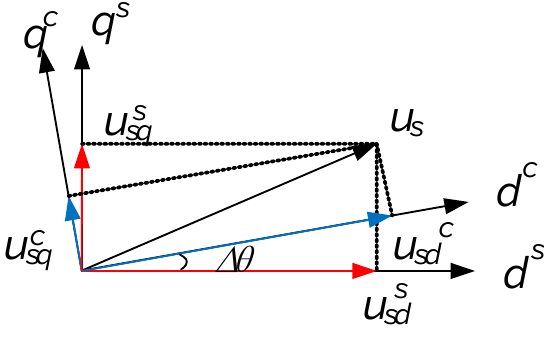
Figure 2. System and phase-locked loop (PLL)